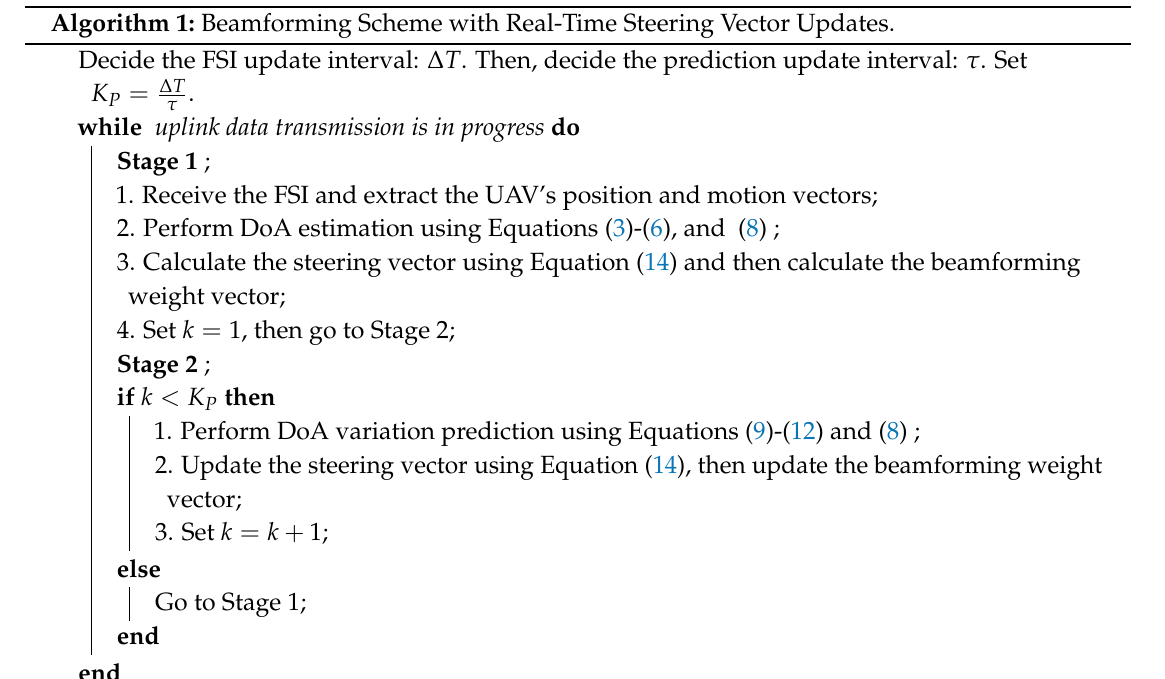
Algorithm 1: Beamforming Scheme with Real-Time Steering Vector